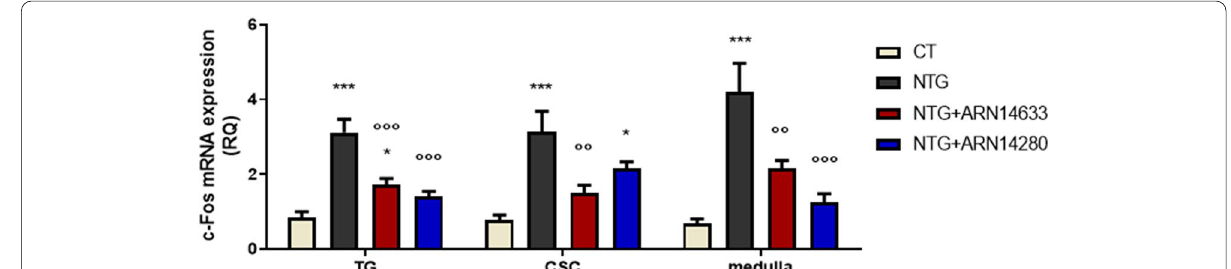
Fig. 3 C-fos mRNA levels (expressed as relative quantification, RQ) in trigeminal ganglion (TG) and cervical spinal cord (CSC) ipsilateral to formalin injection and medulla in toto of animals treated with NTG vehicle (CT), NTG, NTG are expressed as mean